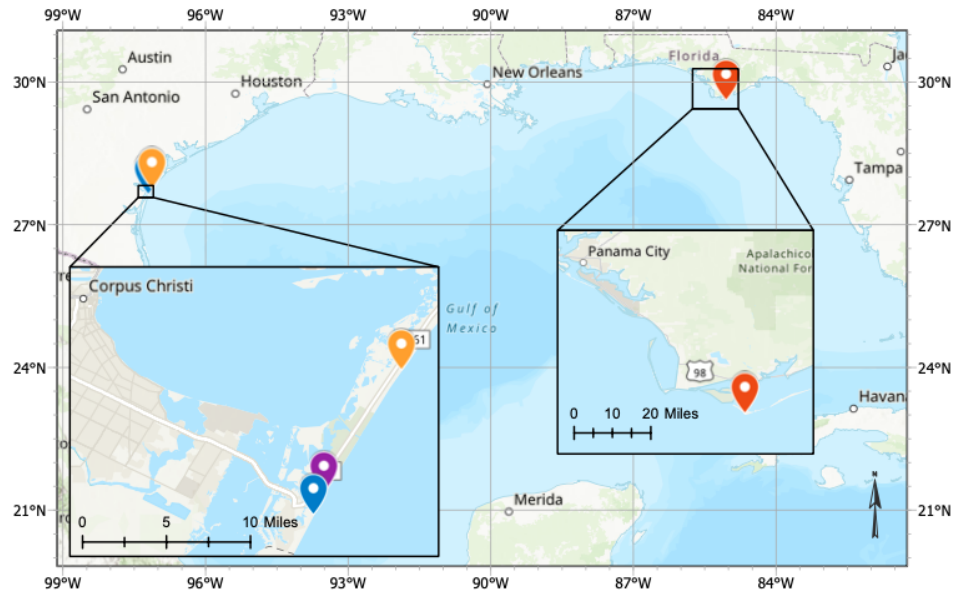
Figure 1. Study Area. Blue pin: Packery Channel; purple pin: Fish Pass; orange pin: Mustang Island SP; red pin: Little Saint George